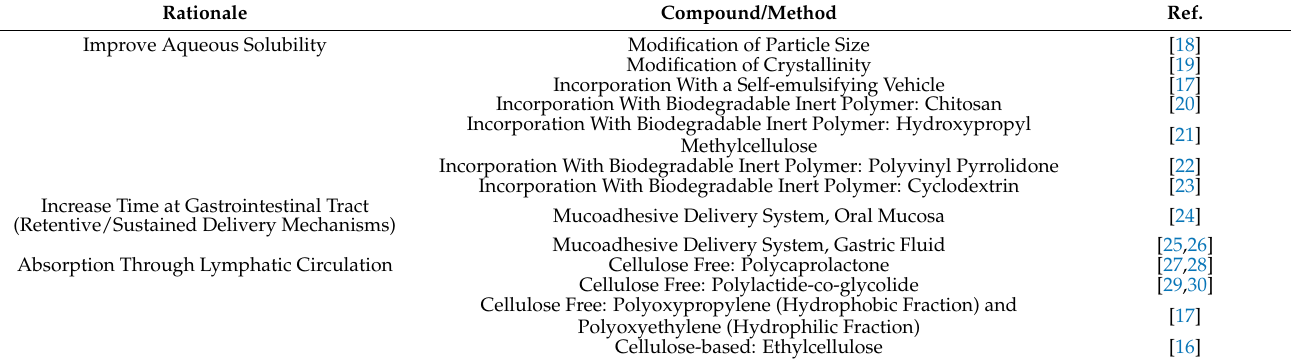
Table 2. Potential methods to increase oral bioavailability of statins.